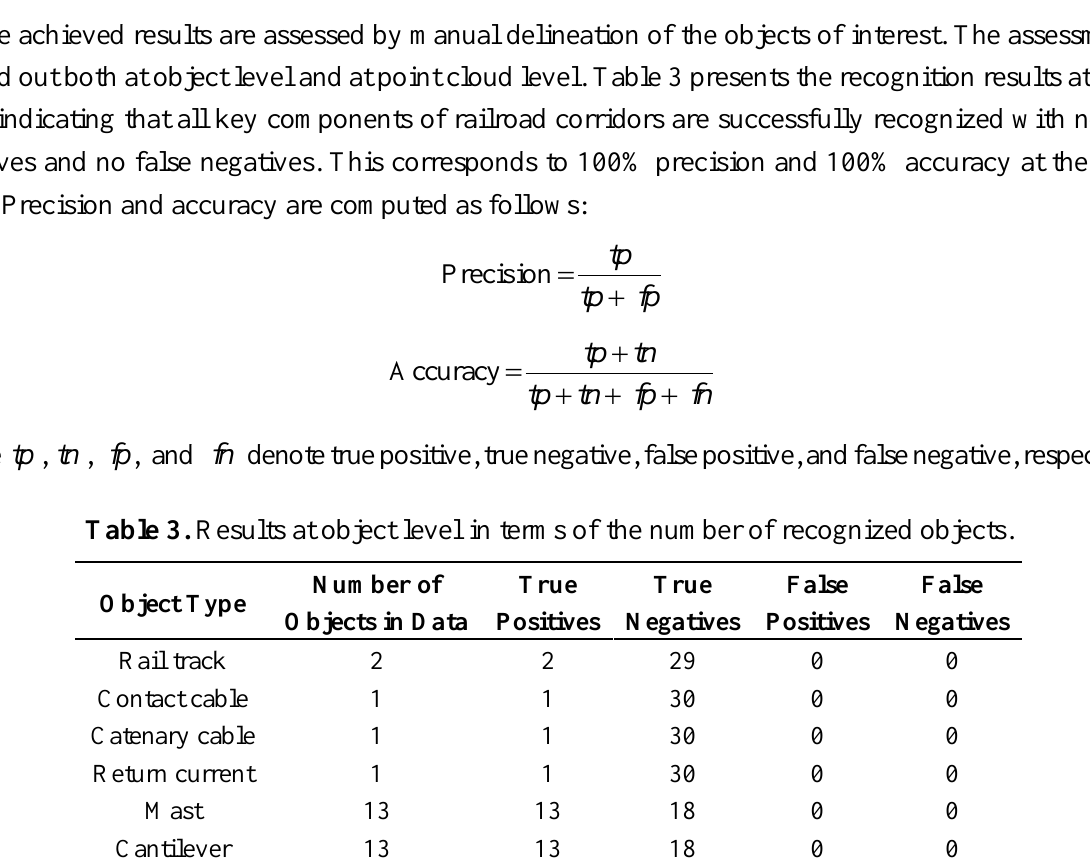
Figure 17. A close-up view of the recognized railroad key elements. Each color represents a separate object, regardless of its type.